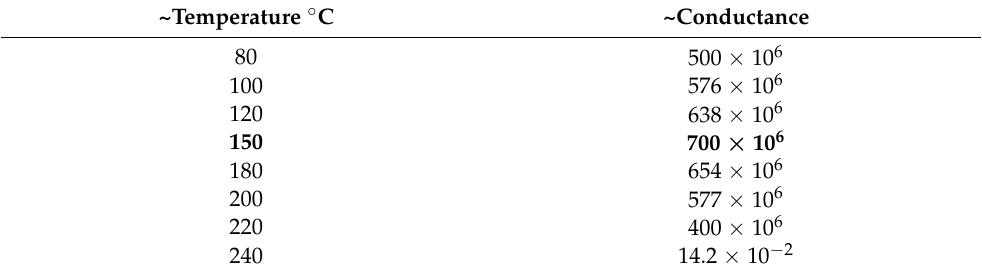
Table 12. Conductance of potassium iodide in methanol at different temperatures. Units were not provided, but the trend in overall values may be used to demonstrate the concepts. Adapted from [19], American Chemical Society, 1956. The bold indicates the temperature of maximum conductance.